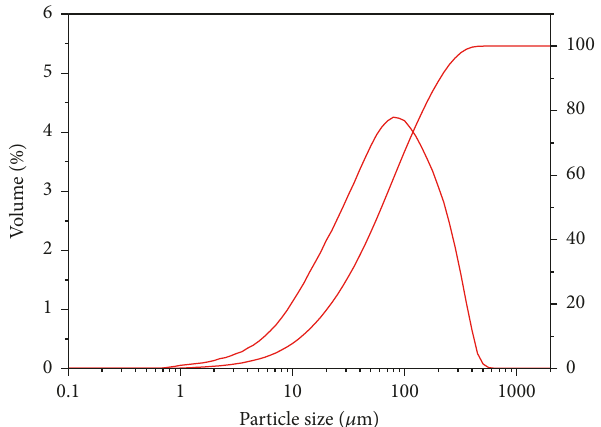
Figure 3: Particle size distribution curves of sugarcane biomass ash.